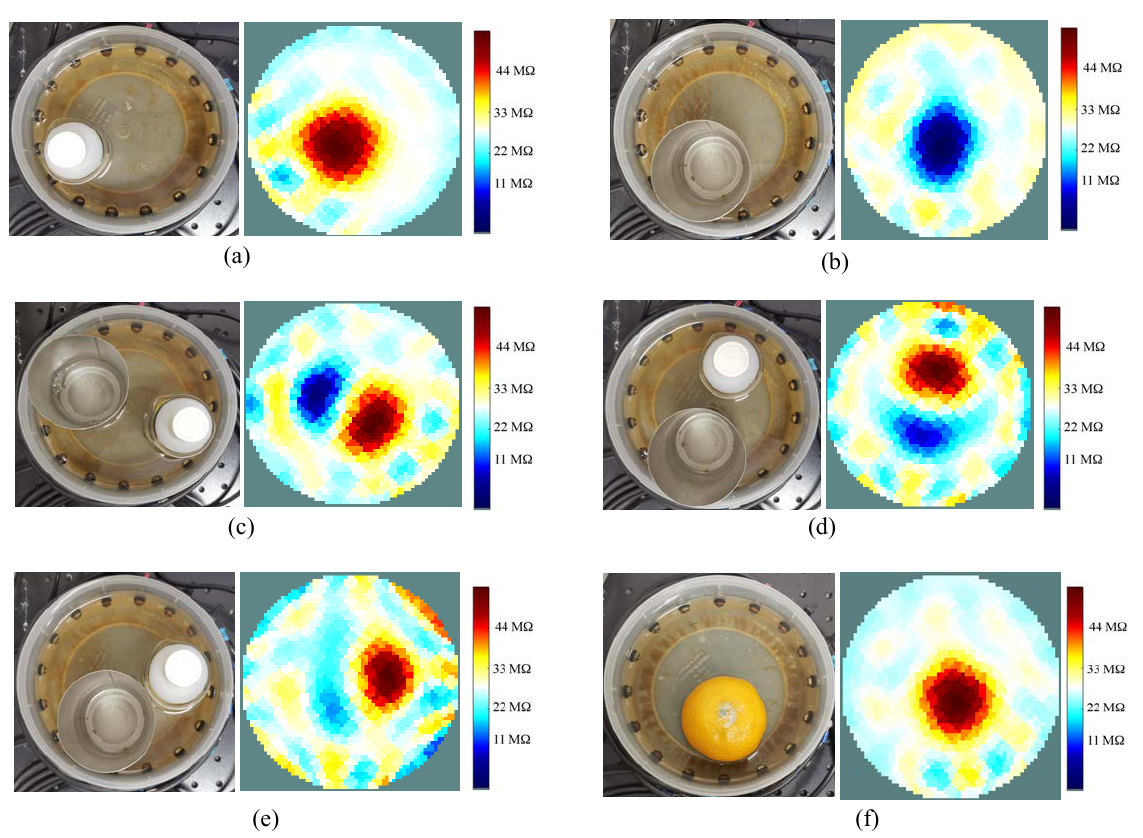
Figure 15. Real-time image reconstruction on RPi4: ( a ) Glass object under test, ( b ) Metal object under test, ( c ) Metal and glass object under test, ( d ) Metal and glass in different positions, ( e ) Metal and glass in different positions, ( f ) An orange under